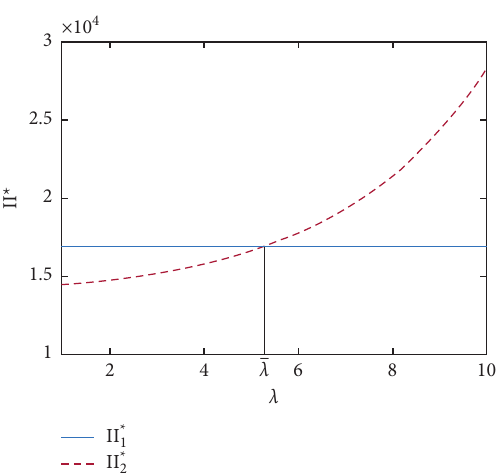
Figure 1: Profitable condition for the retailer to provide LS